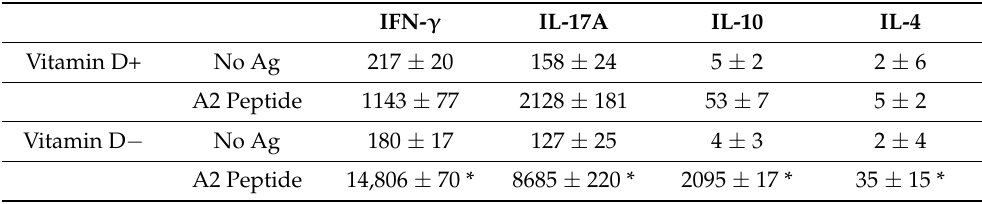
Figure 1. Disease severity in mice fed a vitamin D deficient diet. DBA/1 mice were fed either a vitamin D deficient (Vit D − ) or a vitamin D sufficient (VitD+) control diet beginning at three weeks of age. All animals were challenged with a dose of 100 µg of CII emulsified in CFA for the induction of disease. Mice were scored for arthritis severity ( n = 6 per group). The severity scores are expressed as means ± SEM. Treated mice fed the Vit D − diet were significantly different from controls beginning at day 39 ( p ≤ 0.05 using Mann and Whitney analysis). Table 1. Cytokine responses in splenic T cells from mice fed a vitamin D deficient diet. Splenocytes from DBA/1 mice fed either Vitamin D+ or Vitamin D − diet and previously immunized with CII/CFA were cultured with A2 peptide (3 µmol/mL) or no Ag, then supernatants were analyzed for cytokines ( n = 3 for each group). Values indicated represent the mean ± SEM (pg/mL) of three separate experiments. * p ≤ 0.001.